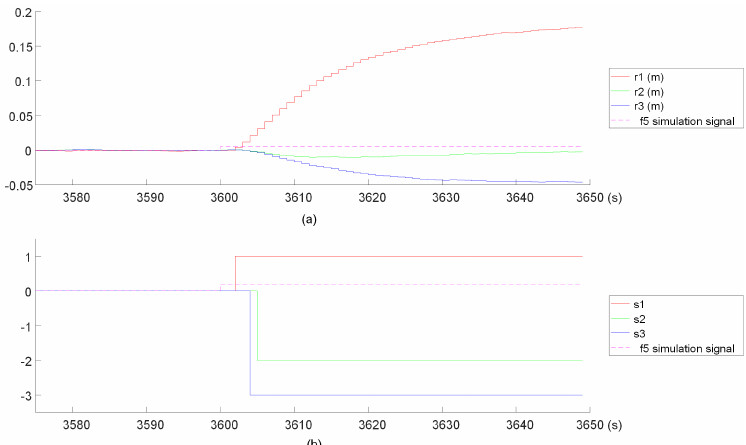
Figure 4. Examples of diagnosing in the case of the f 5 fault: ( a ) residual values and ( b ) diagnostic signal values (three-value signal (cid:104)− 1,0,1 (cid:105) scaled to an s j number). Table 11. The results of the algorithm for the input signals from Figure 4. Algorithm